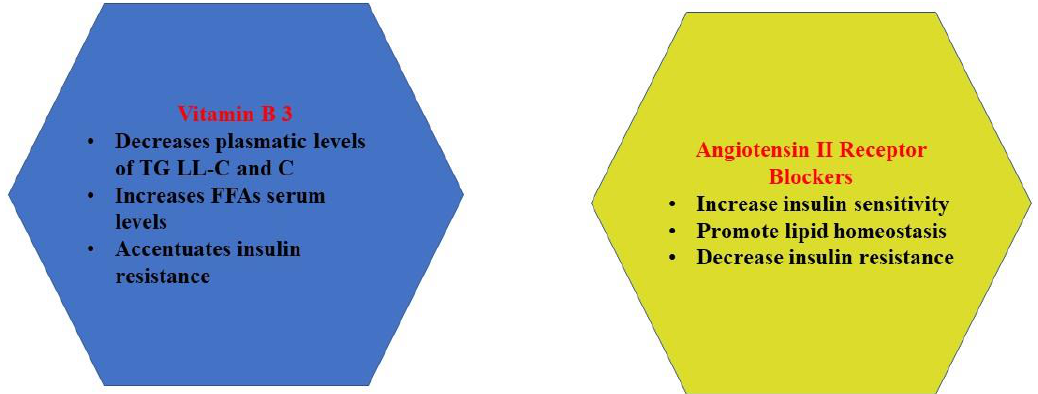
Figure 3. Effects of ACEI and ARBs (Angiotensin II Receptor